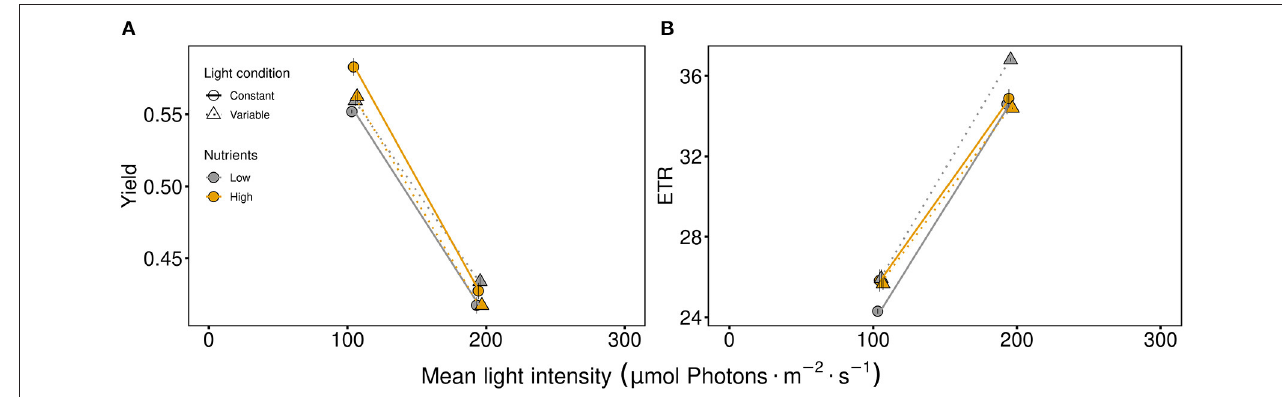
FIGURE 1 | Photosynthetic parameters of the communities: (A) the quantum yield indicating photosynthetic efficiency and (B) the electron transport rate (ETR) as a measure of photosynthetic activity. Communities were either cultivated under variable (triangles, dashed line) or constant (circles, solid line) light conditions. Mean values are shown for high (orange symbols and lines) and low (gray symbols and lines) nutrient supply and are displayed with ± standard